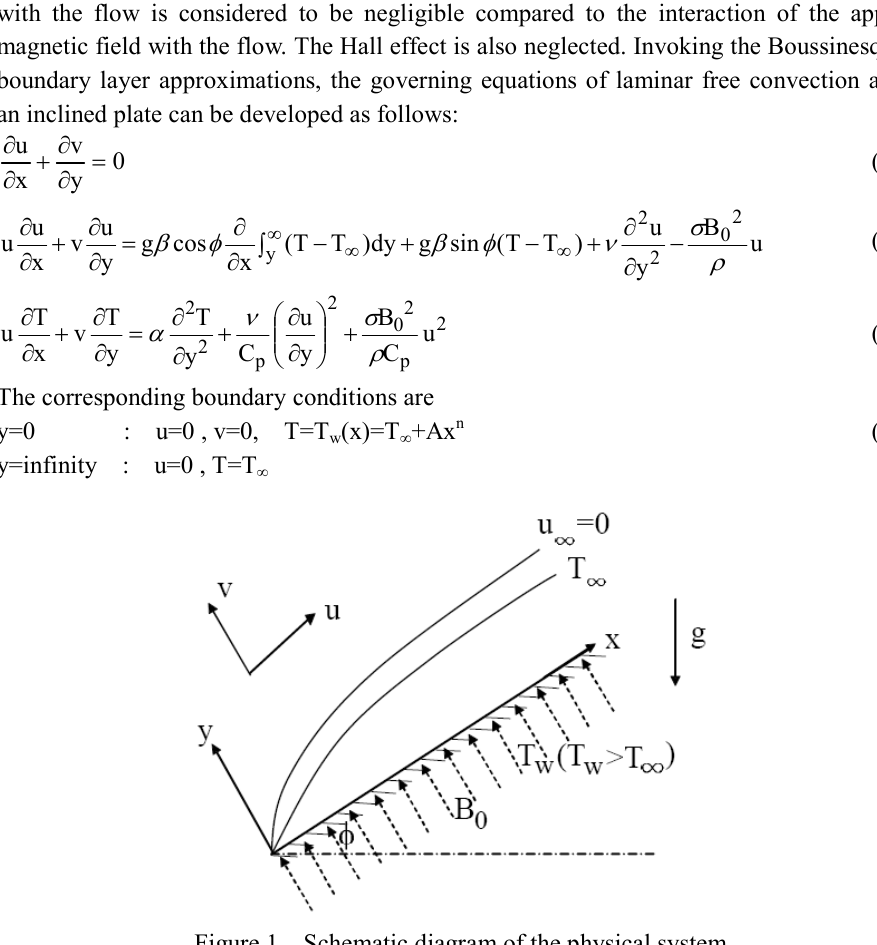
Figure 1 Schematic diagram of the physical